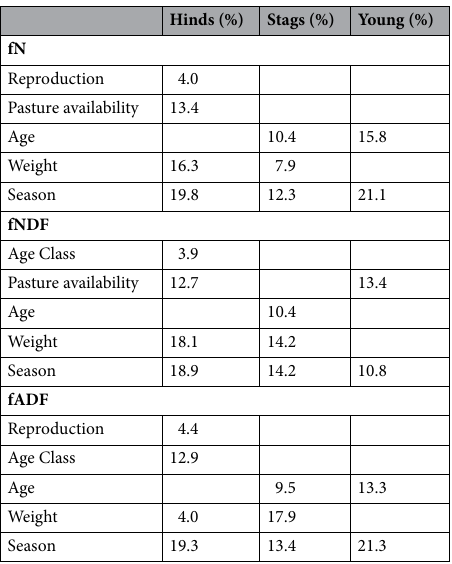
Table 5. Variability induced by the individual and nutritional factors studied in the faecal nutrients (nitrogen—fN; neutral detergent fibre—fNDF; acid detergent fibre—fADF; see Materials and Methods for more details about the